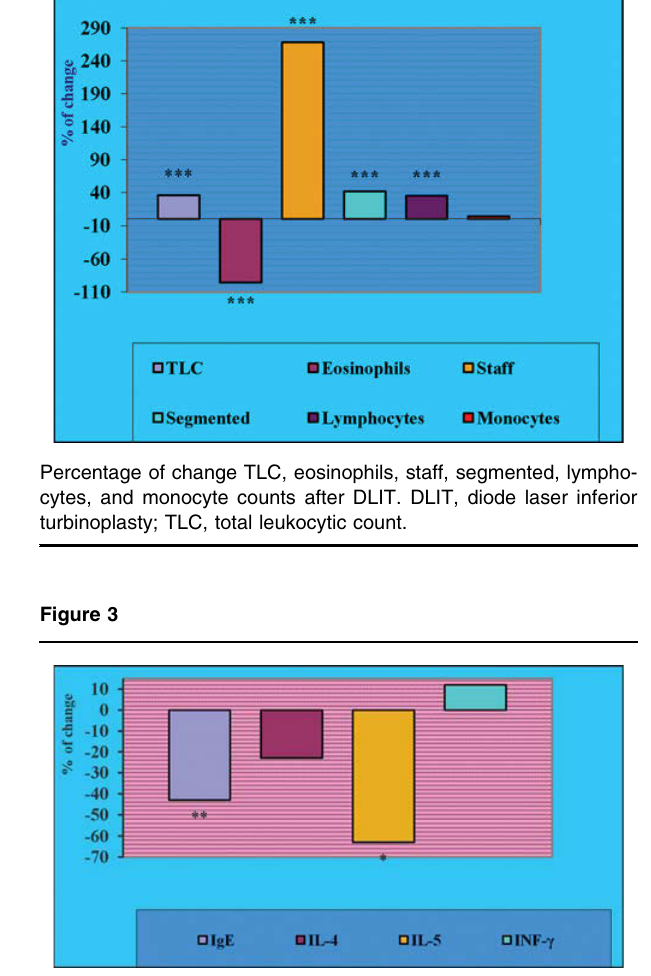
Table 2 Statistical analysis of absolute numbers of the total leukocytic count, eosinophils, staff, segmented, lymphocytes, and monocyte count before and after DLIT